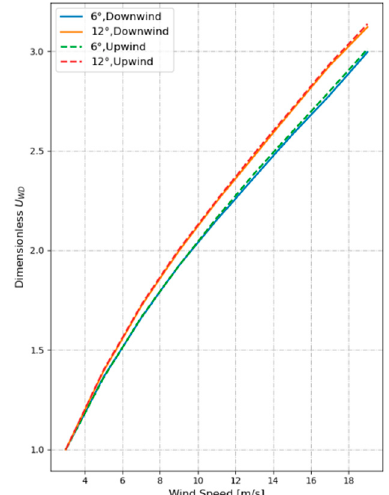
Figure 12. Variation in dimensionless U WD with wind speed for relative wind directions of 0° and 180° and incidence angles of 6° and 12°.